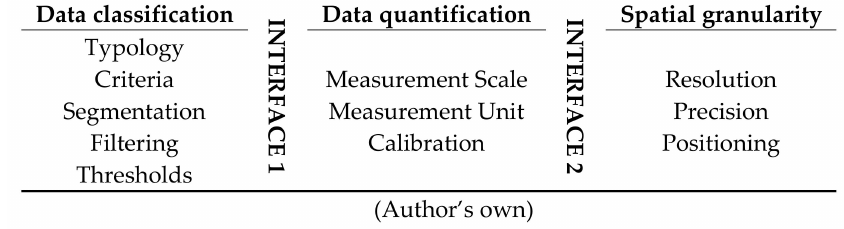
Figure 1. Three Stage Approach to spatial analysis of commercial real estate